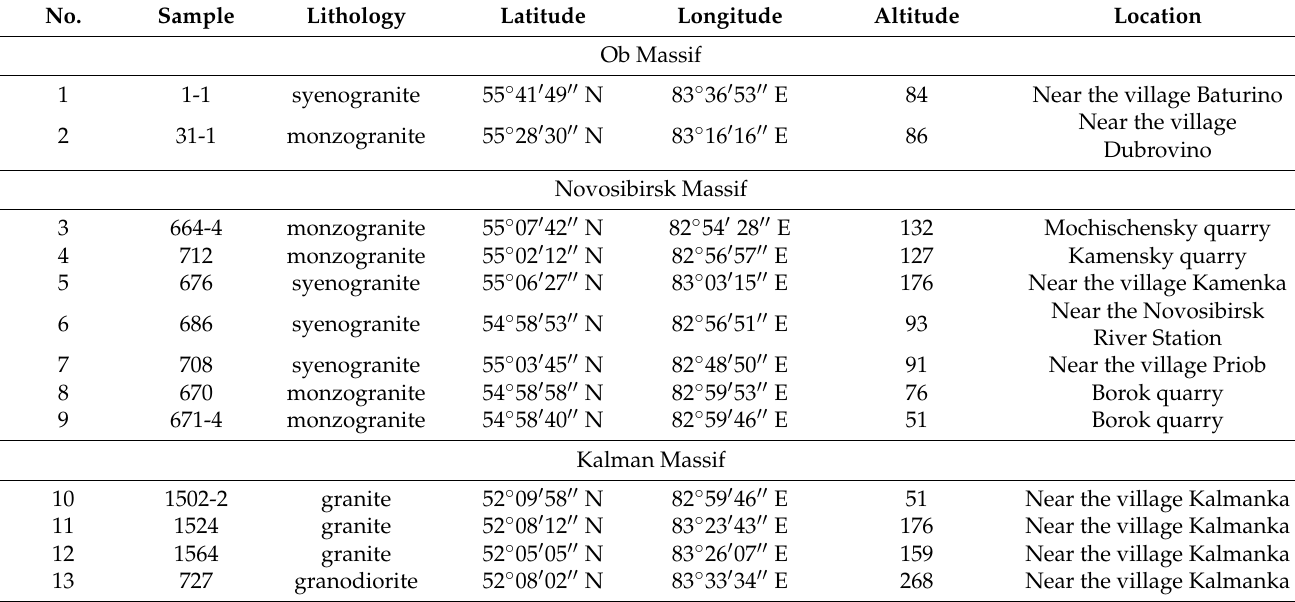
Table 1. Location, lithology, and sample